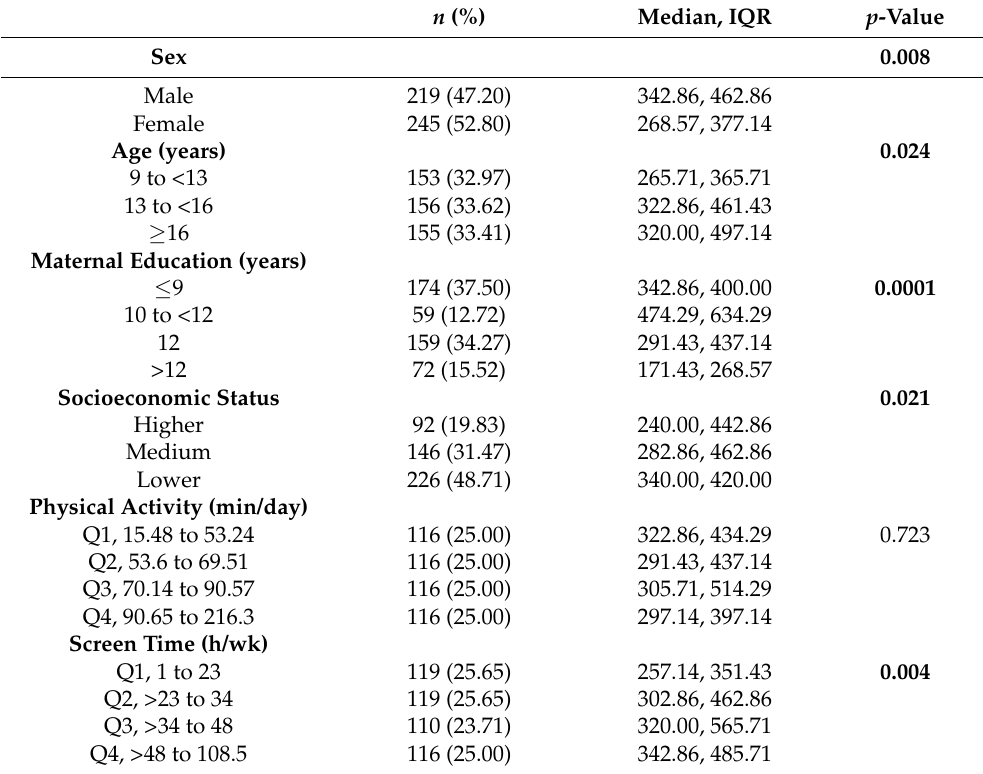
Table 1. Baseline characteristics of study participants and SSB intake in 2015 ( n =